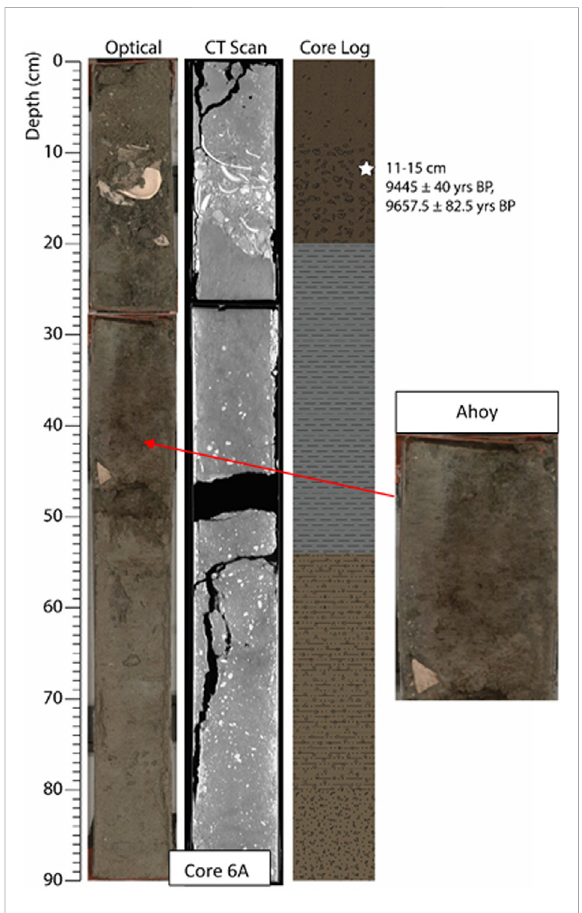
FIGURE 7 Optical, CT, and core log images ofCore 6A with photograph inset of Ahoy (Xeroll) paleosols identi fi ed in core. White star on core log shows location of radiocarbon sample and depth and age are noted. Red arrow shows location of paleosol.